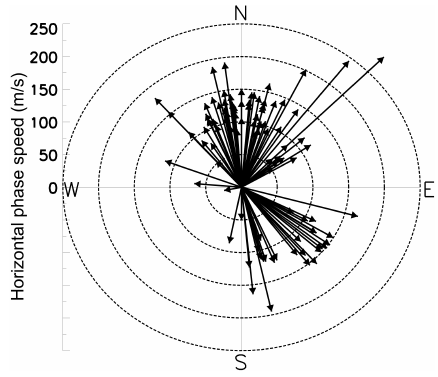
Figure 5. Horizontal phase speed diagram for all observed gravity waves. Arrows point in the direction of propagation of the gravity waves. The dashed lines indicate isolines of the same phase